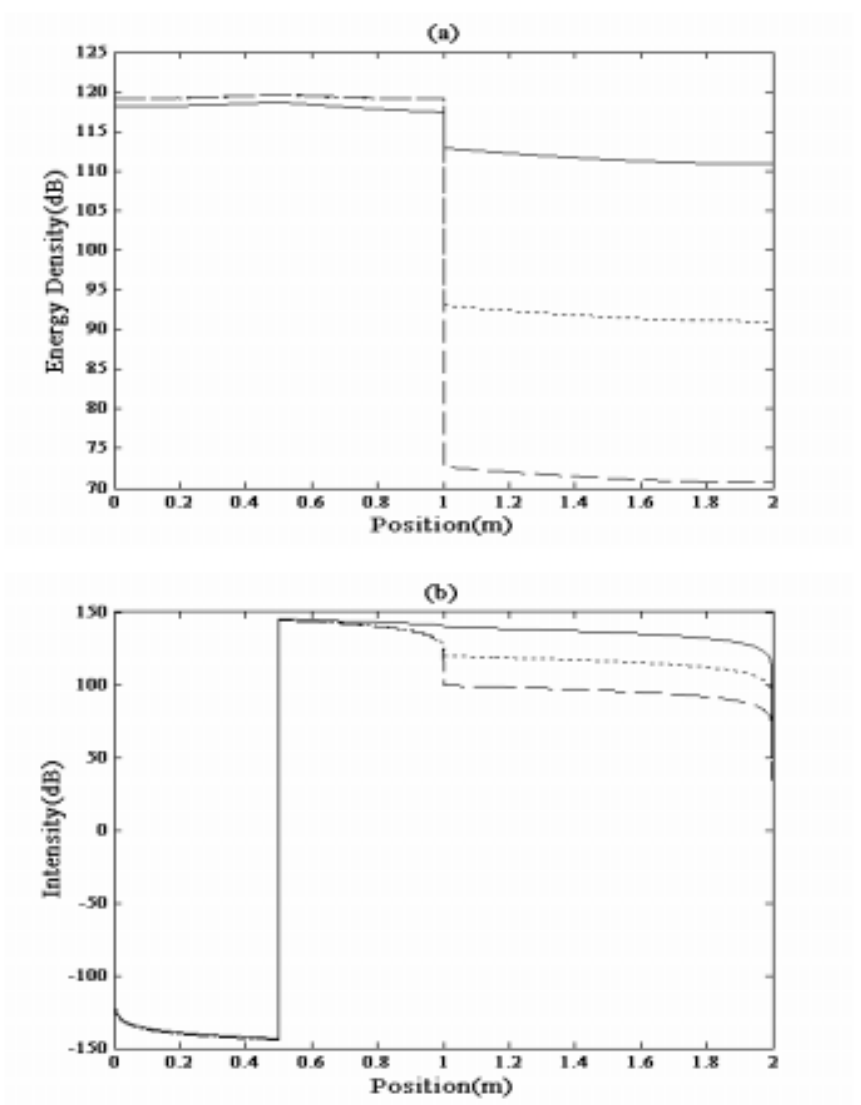
Fig. 4. Energy and intensity distributions of two-beam structure coupled with Φ = 90 ◦ when f = 1 kHz and η = 0.1. (a) flexural wave energy, (b) flexural wave